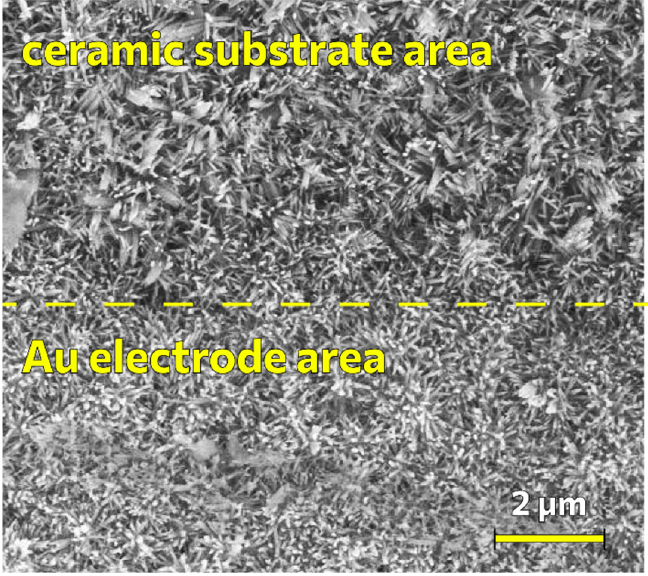
Figure 6. SEM micrograph of ZnO nanorods on the surface of a ceramic substrate with interdigitated Figure electrodes.